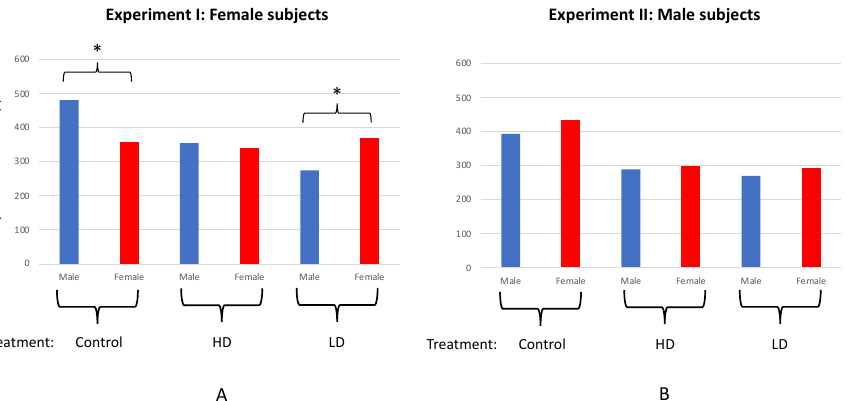
Figure 3. Comparison of mean time spent in association with the male vs. female dummy stimuli in AZT ‐ exposed vs. unexposed females ( A ) and males ( B ) from expts. I and II, respectively. ‘HD’ and ‘LD’ refer to subjects from the high ‐ and low ‐ dose exposure groups, respectively. Starred brackets (*) indicate a significant difference in mean time spent with the male vs. female dummy stimulus within a given treatment group (e.g., time LD females spent with the male vs. female dummy) using paired sample t ‐ test.